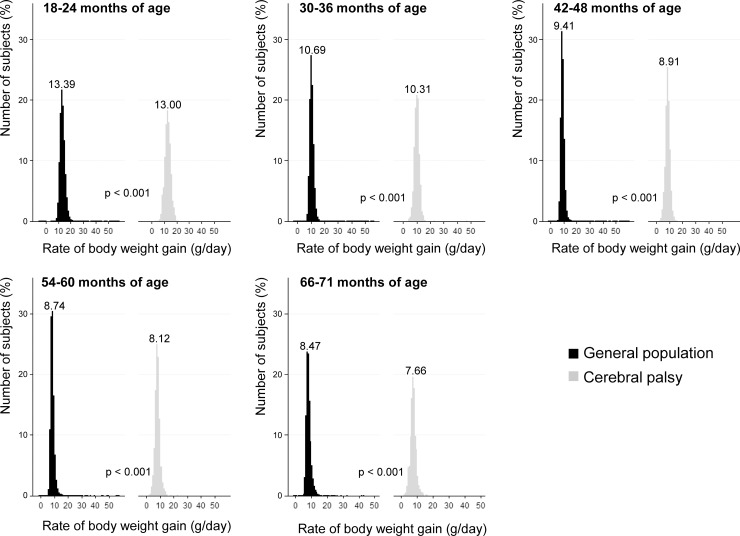
Comparison of the rate of body weight gain.Comparisons were made between the subjects in the general population and the subjects with cerebral palsy at each National Health Screening Program for Infants and Children. The number on each graph is the mean value of body weight for the subjects in the general population and subjects with cerebral palsy.